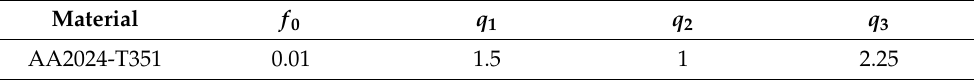
Table 2. GTN parameters adopted in the numerical model. Note that nucleation was neglected.